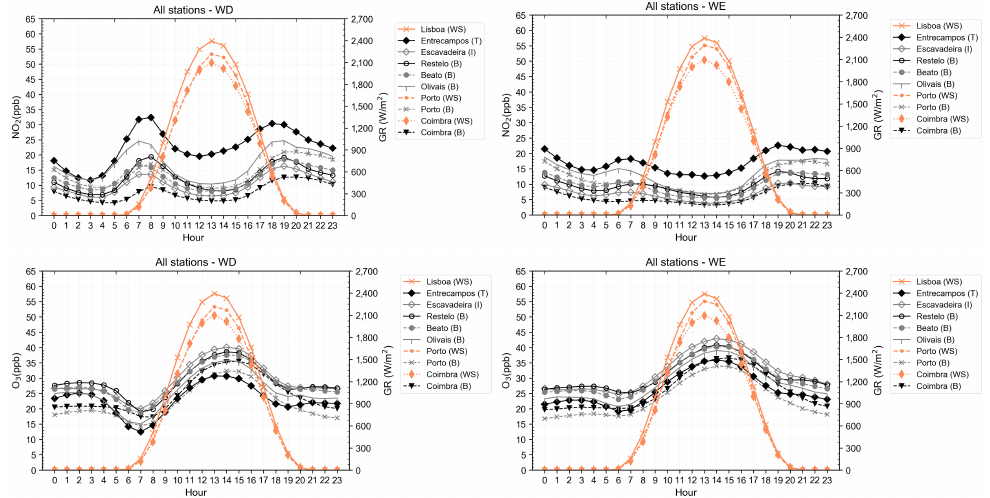
Figure 13. Mean values of all years data and all AQMS and WS. Daily WD ( left ) and WE ( right ) differences for NO 2 and O 3 (top to bottom) are represented. Table 3. Pearson correlation table for all AQMS data (N = 424,891). Variables